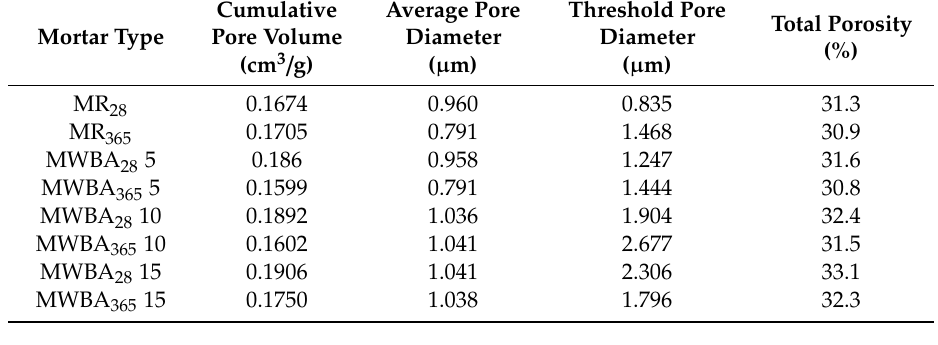
0.000.050.100.150.200.25